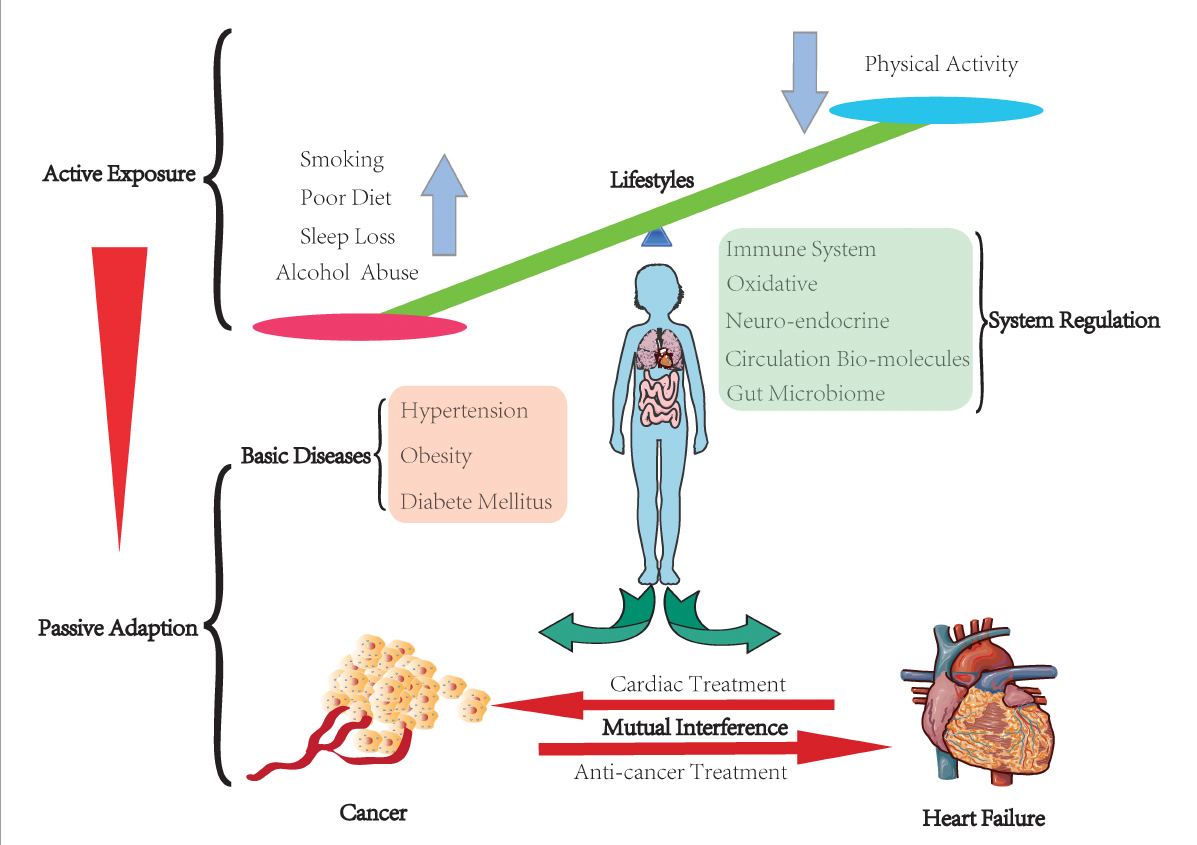
FIGURE1 Balance in the human body. The human body keeps the balance through people actively exposing to their lifestyles, which leads to various inter-environment. Some of them have to face their basic diseases. The body has to passively adapt to this inter-environment by arousing the system regulation to correct those temporary unbalance or compensate to a certain pathological state. Furthermore, cancer and heart failure have mutual